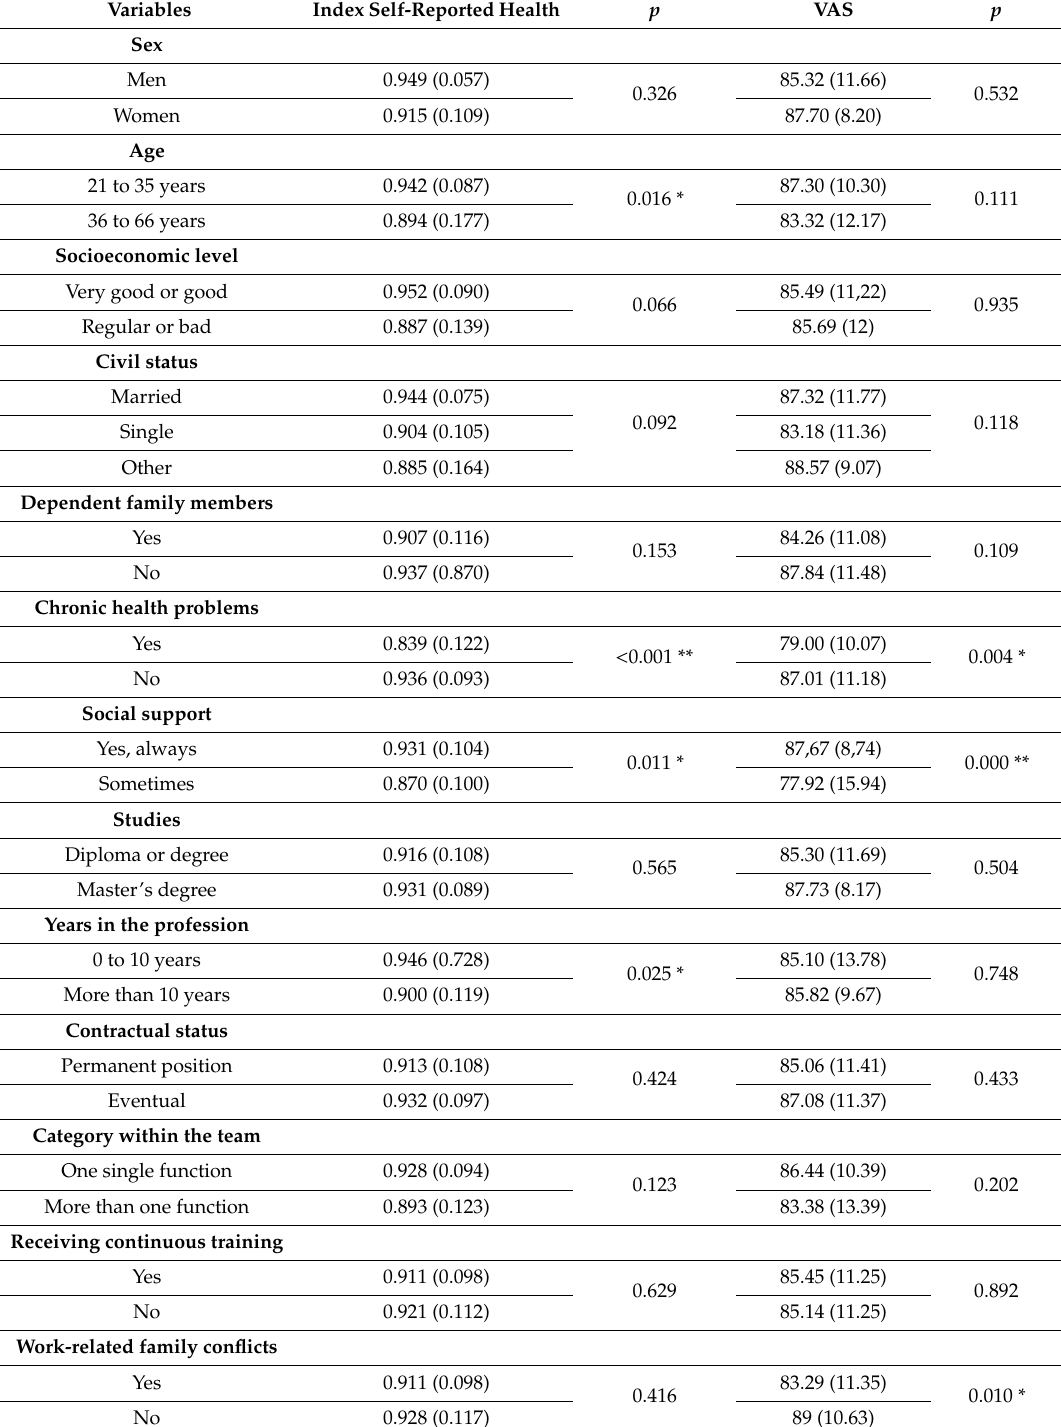
Table 2. Self-reported health scores by sociodemographic, occupational and health variables ( n = 109).